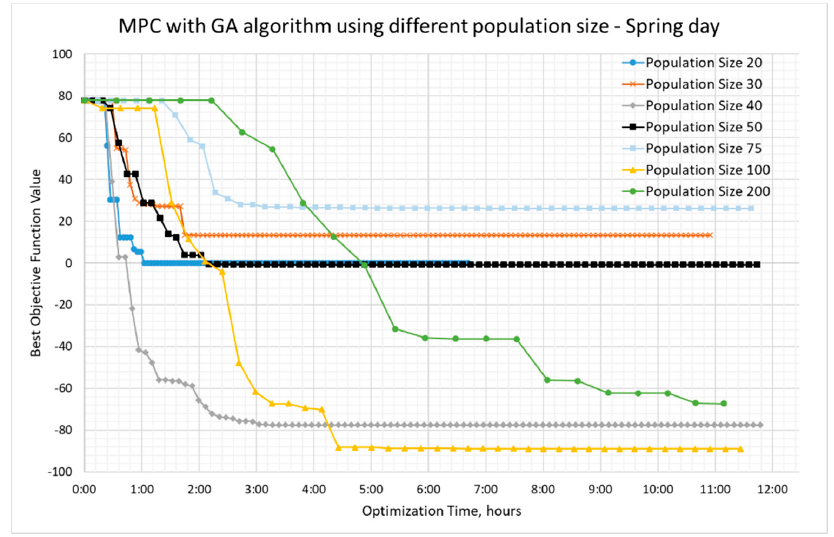
Figure 10. GA optimization results on the spring day with different population size.